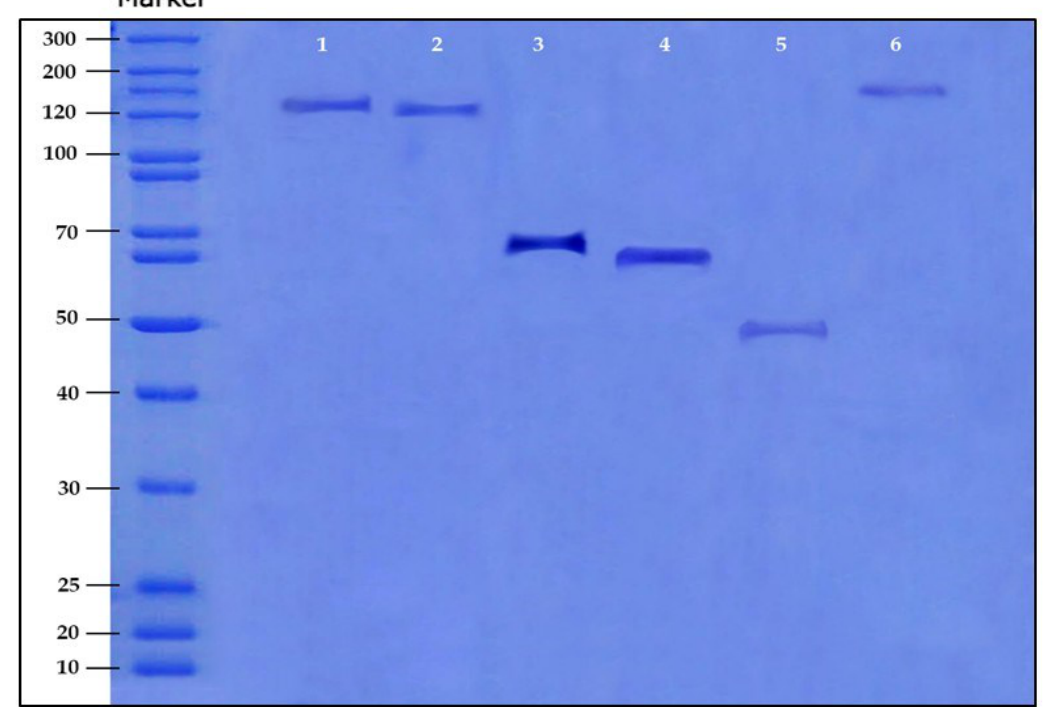
Figure 1. Sodium Dodecyl Sulfate Polyacrylamide gel electrophoresis (SDS-PAGE) chromatogram of the different protein extraction methods (Lane 1: High temperature/high pressure (HTHP), Lane 2: High temperature, Lane 3: Alkali/high-temperature degumming, Lane 4: Alkali/high-tempera- ture/high-pressure degumming, Lane 5: Acid-degumming and Lane 6: Urea buffer).